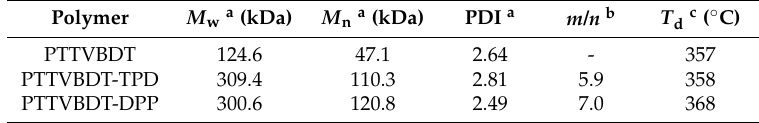
Table 1. Polymerization results and thermal properties of